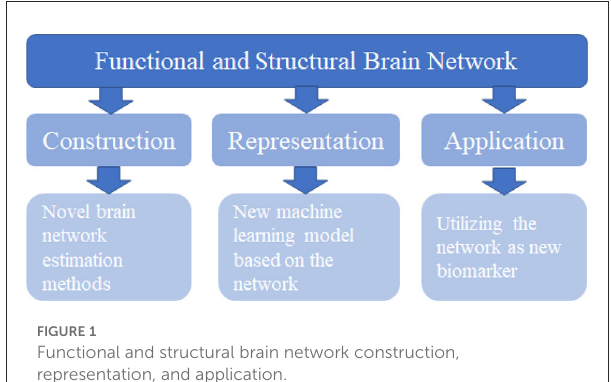
FIGURE1 Functional and structural brain network construction, representation, and